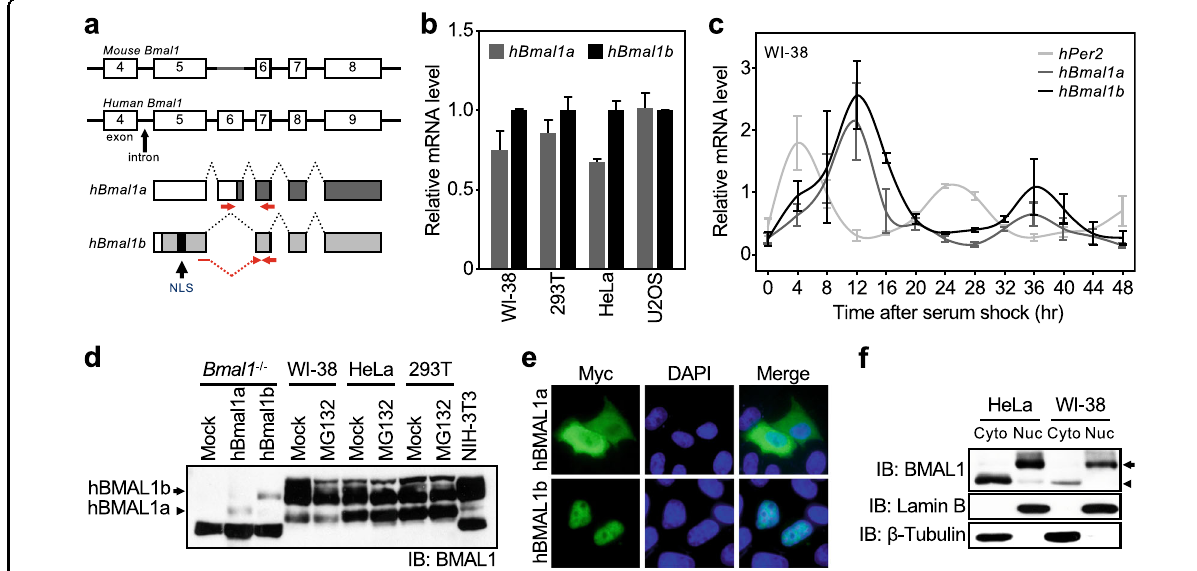
Fig. 1 Expression of human Bmal1 splice variants. a Schematic of the human and mouse Bmal1 genes. b Expression of hBmal1a and hBmal1b mRNAs was analyzed by qPCR in various human cell lines. c Circadian expression pro fi les of hBmal1a (dark gray line), hBmal1b (black line), and hPer2 mRNAs (light gray line) were analyzed in human fi broblasts, WI-38 cells, by qPCR. d Expression of the endogenous hBMAL1a and hBMAL1b proteins was analyzed in several human and mouse cell lines by western blotting. For a size reference, exogenous hBMAL1a or hBMAL1b was expressed in Bmal1 − / − mouse embryonic fi broblasts (MEFs). e The subcellular localization of Myc-tagged hBMAL1a or hBMAL1b was observed under a fl uorescence microscope after immuno fl uorescence staining using an anti-Myc antibody. f Expression levels of endogenous hBMAL1a (arrowhead) and hBMAL1b (arrow) in nuclear (Nuc) or cytoplasmic (Cyto) fractions of HeLa or WI-38 cells were investigated by western blotting. Subcellular fractionation was validated by western blotting using anti- β -Tubulin (cytoplasm) or anti-Lamin B (nucleus)